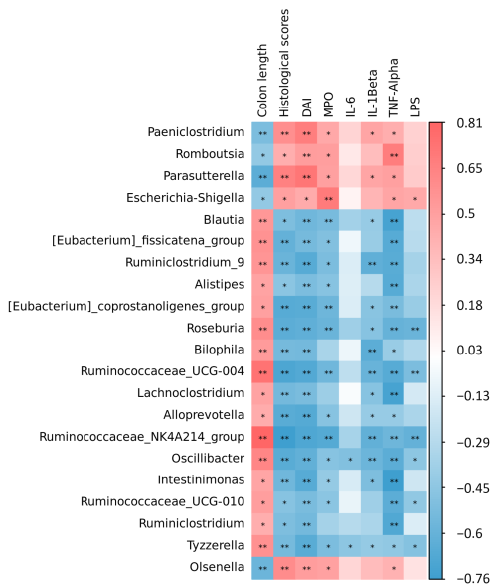
Figure 6. Spearman correlation between colitis indexes and top 50 genera in terms of abundance of the intestinal flora. Correlations with p < 0.05 were considered significant. * Significantly different ( p < 0.05) between bacteria and colitis-related indicators by t -test, ** Significantly different ( p < 0.01) between bacteria and colitis-related indicators by t -test.